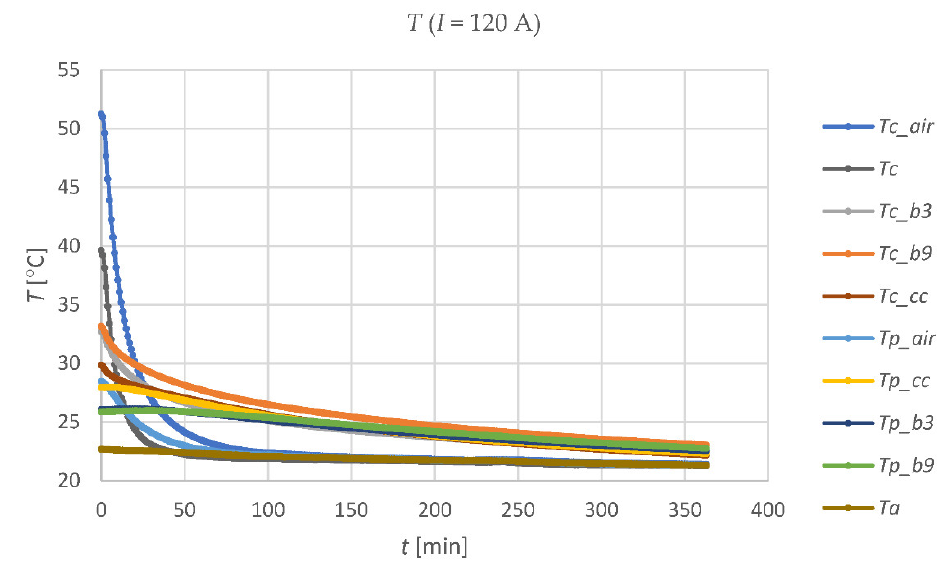
Figure 6. Temperature charts on the test stand after switching off the 120 A current.